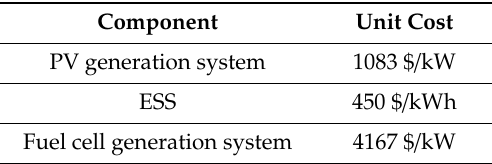
Table 3. Unit cost by system components.